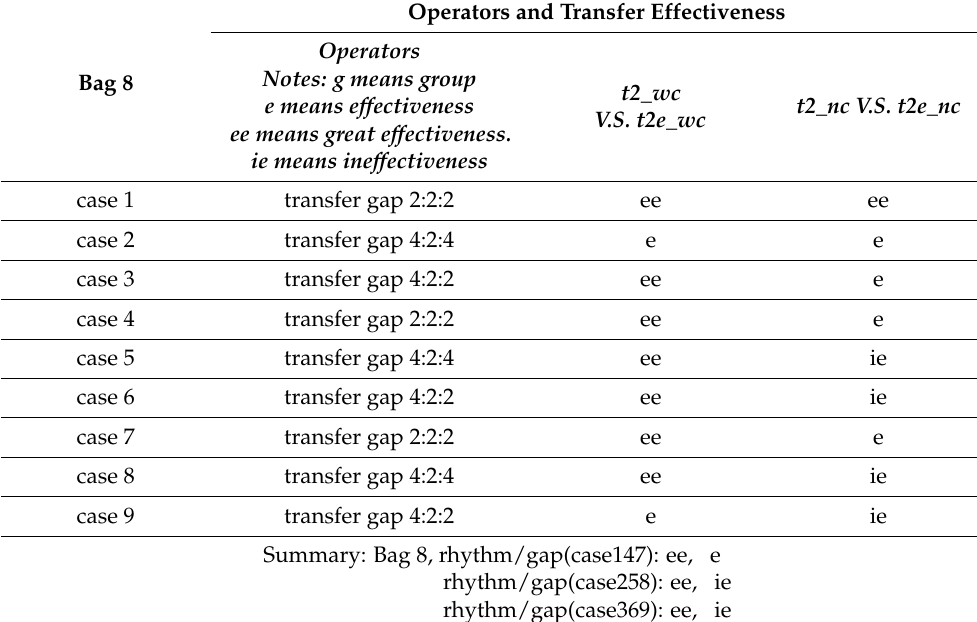
Table 4. Comparisons in Bag 8 for ETO_PFSP